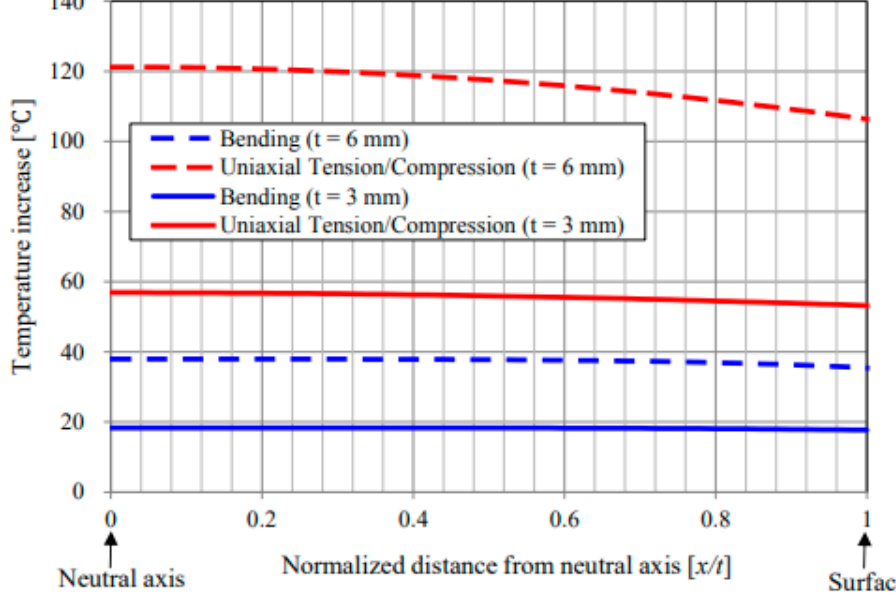
Figure 62. The cross-sectional temperature distribution in laminated GFRP composite specimens with thicknesses of 3 and 6 mm estimated under the assumption of one-dimensional heat transfer [178,183].